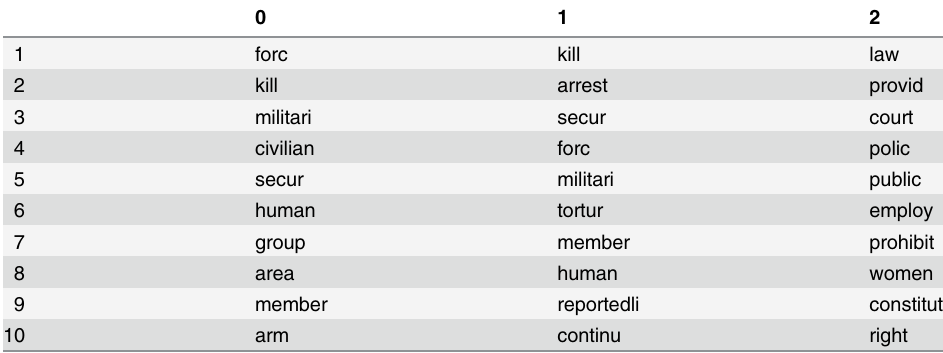
Table 4. Ten most important words for the CIRI Disappearance variable. 0